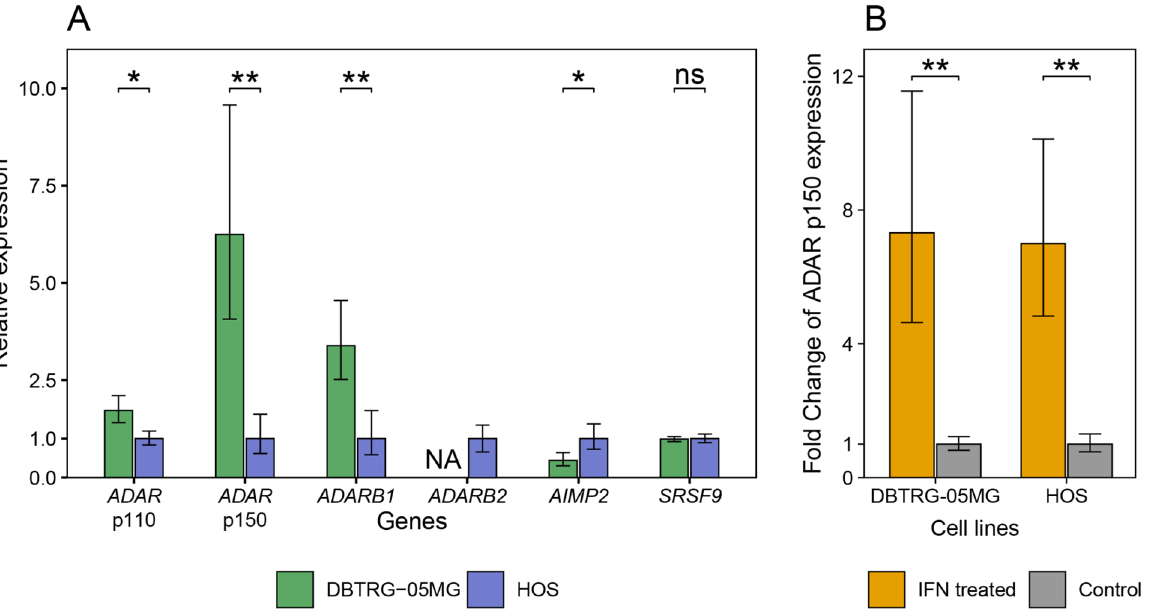
Figure 3. Gene expression of enzymatically active ADAR isoforms and functionally related products in DBTRG-05MG and HOS cells before and after treatment by an interferon α 2 β . ADAR gene products are represented by short nuclear p110 and long cytoplasmic p150 splice isoforms, both encoding ADAR1 enzymes. ADARB1 encodes a second enzymatically active protein of the family, ADAR2. ADARB2 encodes an enzymatically inactive, possibly inhibitory ADAR3 protein [18]. AIMP2 [21] and SRSF9 [22] products downregulate ADAR RNA editing in some human tissues. In the figure: ( A ) Baseline gene expression levels in cell lines of interest before the treatment; and ( B ) a range of the ADAR p150 splice isoform induction after the interferon treatment. Other products of interest did not change their expression upon treatment (not shown). All measurements were performed in four biological repeats with three technical replicates. Bar heights display the sample mean, and whiskers span the 95% confidence interval between biological replicates. * p < 0.05, ** p < 0.01, t